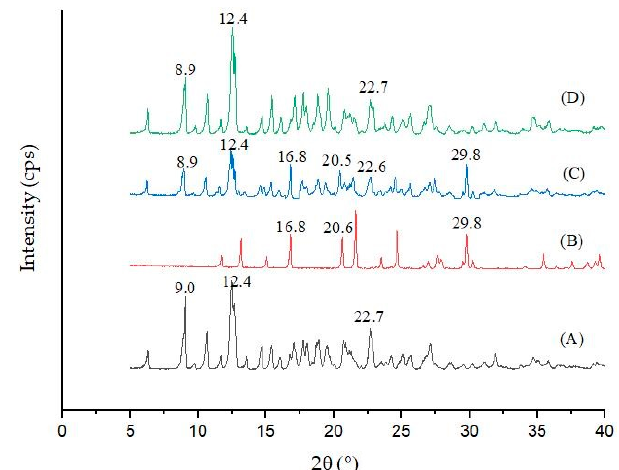
Figure 4. X-ray diffraction (XRD) results: ( A ) β -CD; ( B ) diuron; ( C ) physical mixture; and ( D ) the inclusion complex.